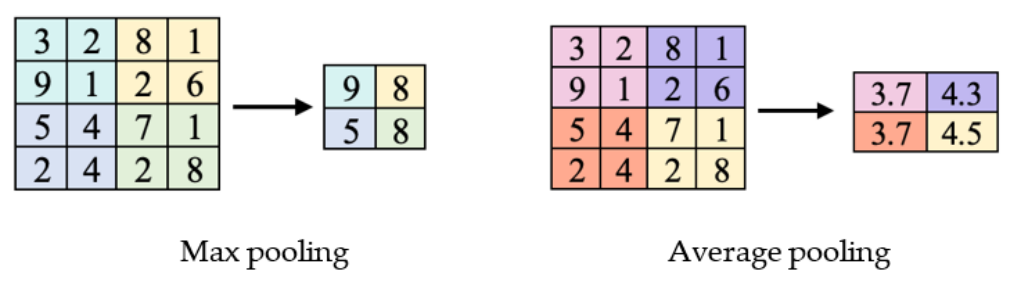
Figure 8. Different pooling types used in CNNs.